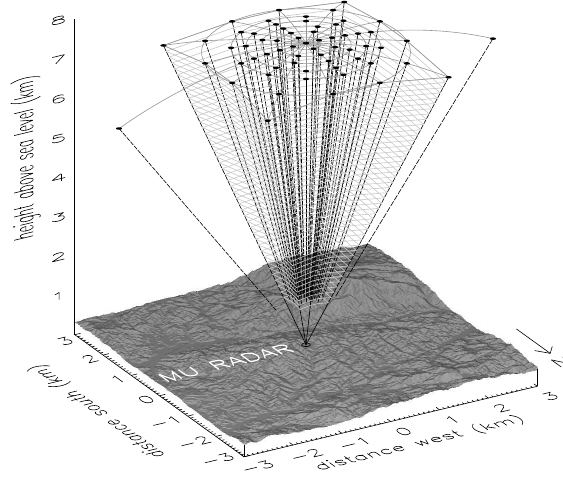
Fig. 1. Three-dimensional view of the MU radar (34.85 ◦ N, 136.10 ◦ E) in a volume-imaging mode with 64 beams at 0 ◦ , 2 ◦ , 4 ◦ , 6 ◦ , 8 ◦ , 10 ◦ , 14 ◦ , 20 ◦ , 30 ◦ from zenith. Dots are beam directions, dashed lines are 150-m range gates, grey lines are at constant range from the radar, with circular grey lines at constant zenith angle, and shaded surface is land height. Azimuth separation of the grey lines across zenith is 15 ◦